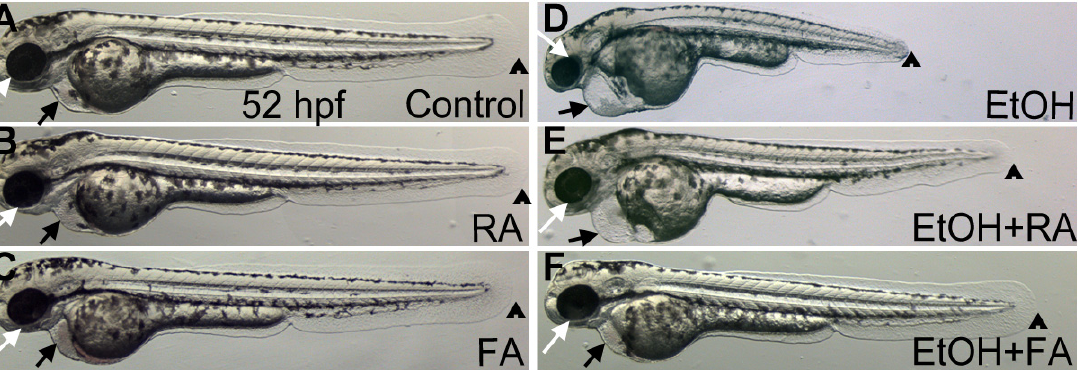
Figure 3. Retinoic acid or folic acid supplementation with ethanol during zebrafish embryogenesis significantly rescues ethanol induced morphological defects. ( A – C ) Lateral view of live images showed normal embryonic morphology in the control, 1 nM RA and 75 μ M FA treated embryos at 52 hpf. ( D ) Ethanol treated (150 mM) embryos exhibited shorter body, small eye, and heart edema at 52 hpf. ( E ) Ethanol (150 mM) and RA (1 nM) co-treated embryo showed rescue of ethanol-induced small eye and short body length defect, but not the pericardial edema. ( F ) Ethanol (150 mM) and FA (75 μ M) co-supplementation rescued most of ethanol-induced defects including shorter body, small eye, and heart edema. Ethanol plus FA supplemented embryo ( F ) showed normal morphology at 52 hpf. Black arrow indicates heart; white arrow indicates eye; arrowhead indicates posterior end of the embryo. Based on